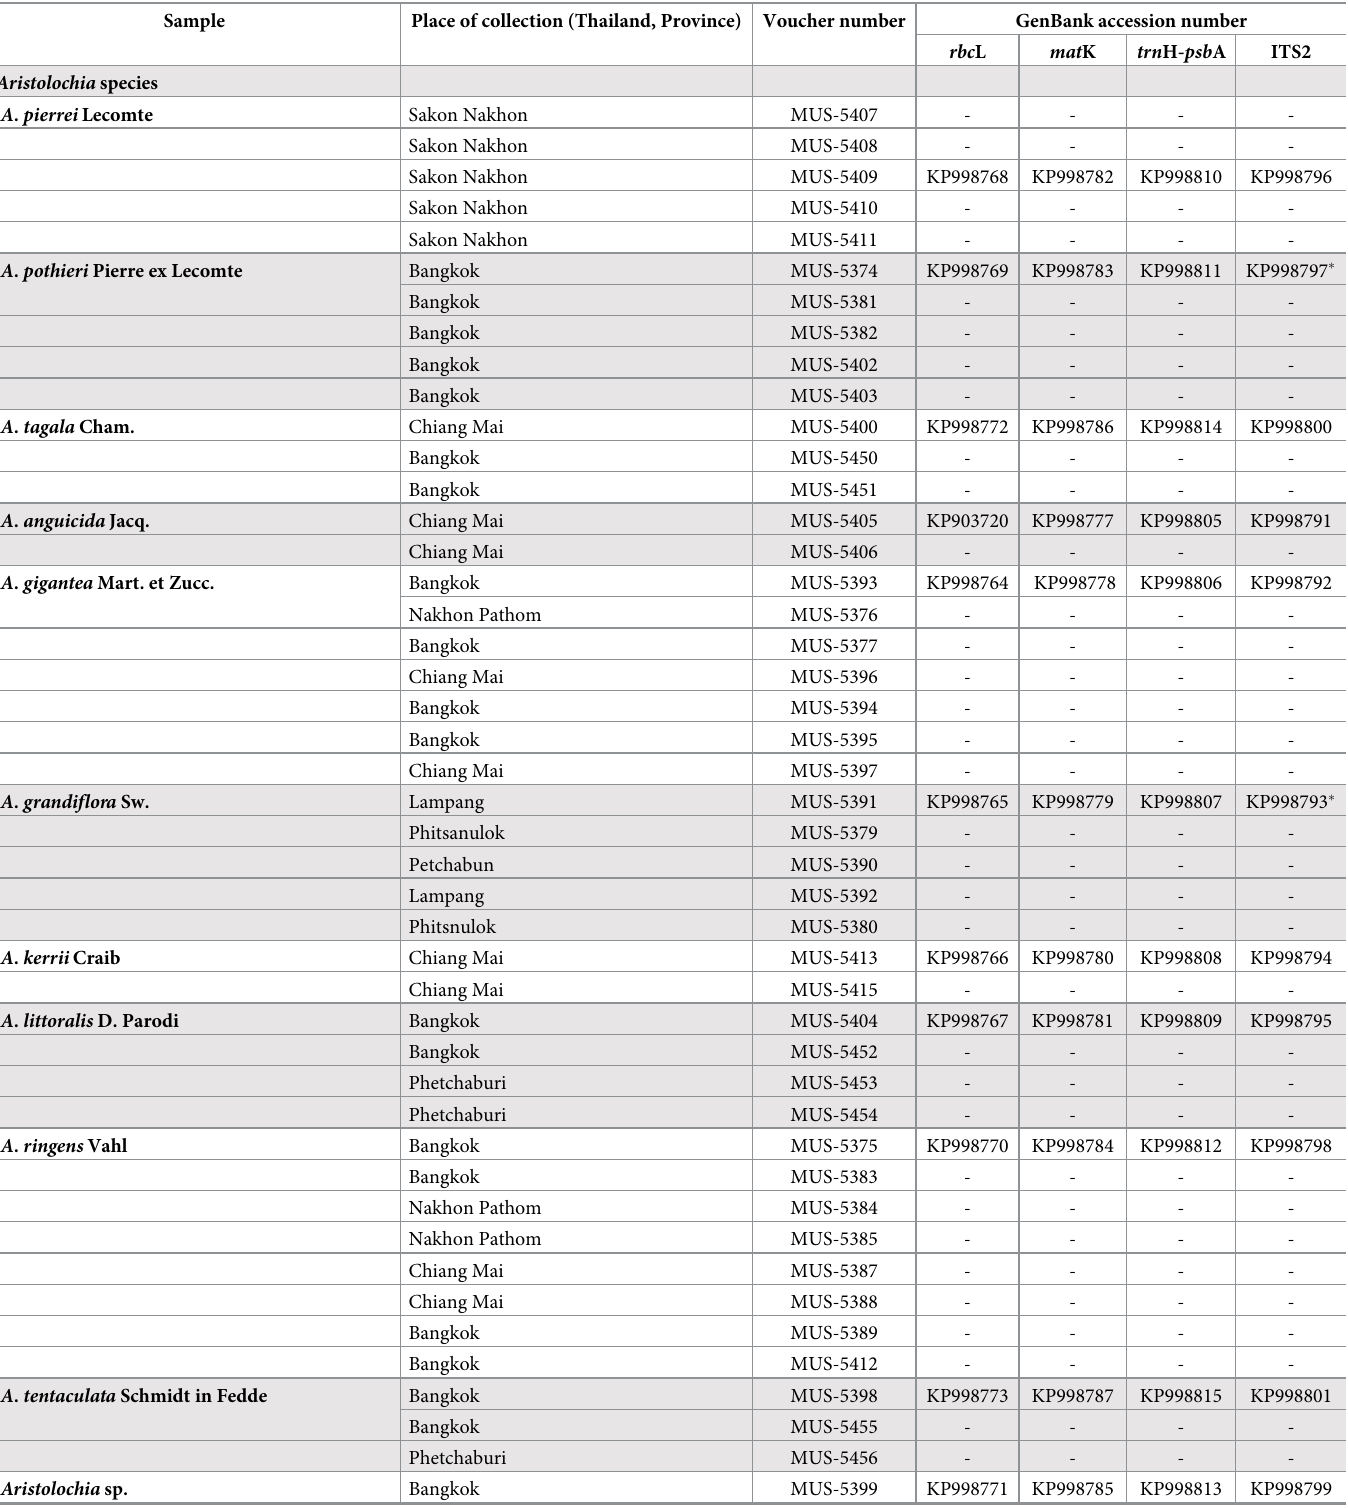
Table 1. Plant materials and crude drugs used in this study.